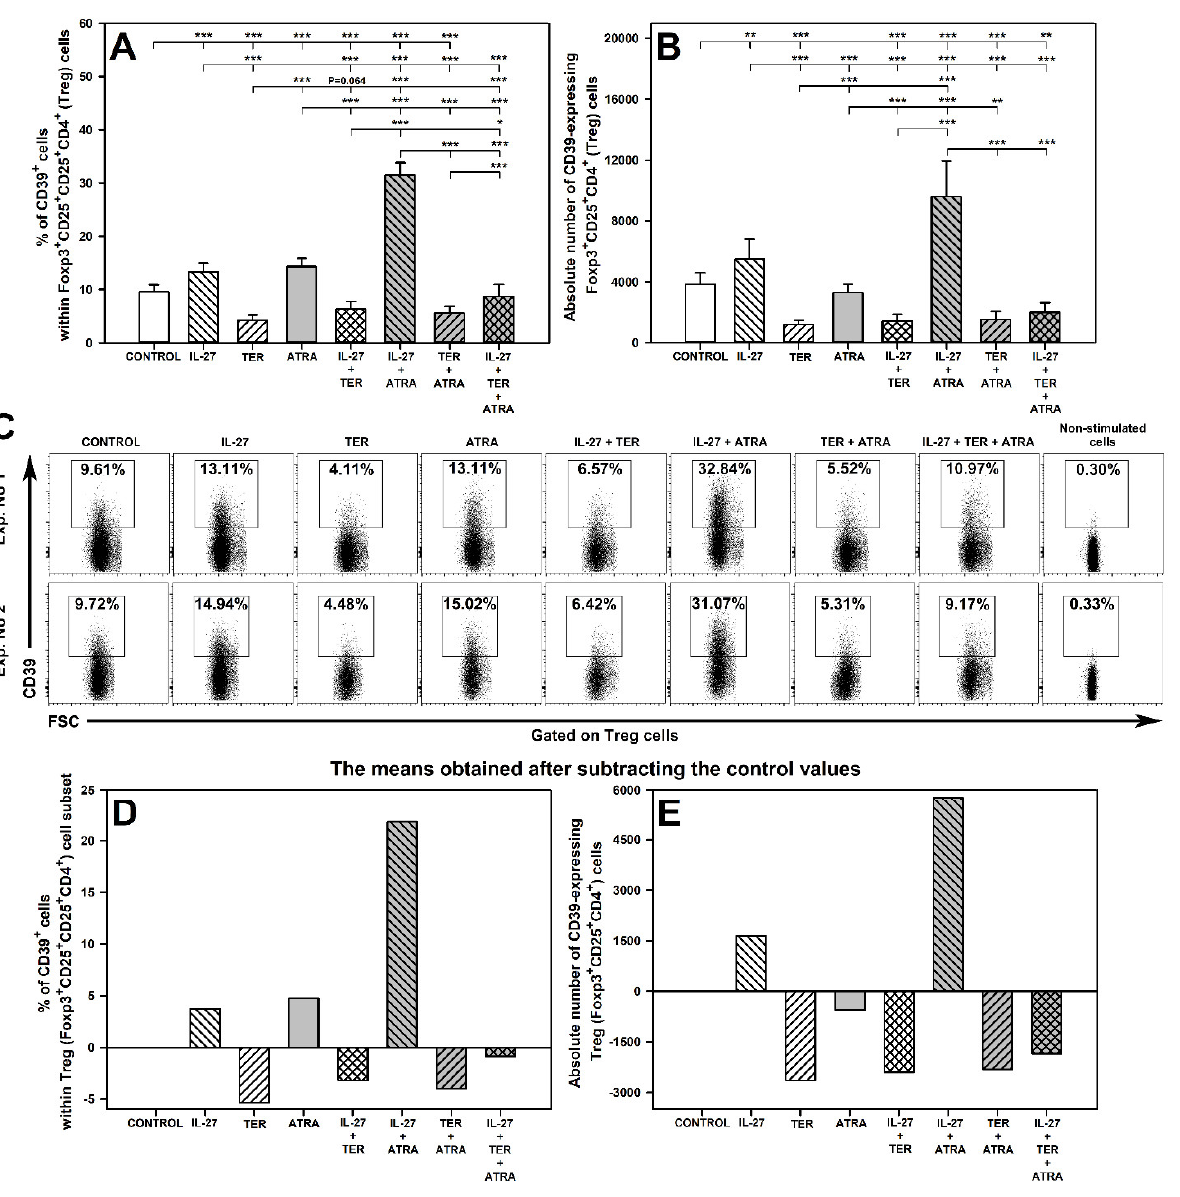
Figure 4. Effect of IL-27, teriflunomide (TER), all-trans-retinoic acid (ATRA), and their combinations on the number of CD39-expressing Foxp3 + CD25 + CD4 + regulatory T (Treg) cells under activation conditions. The relative ( A ) and absolute count ( B ) of these cells were determined in cell cultures incubated in the absence (CONTROL) and presence of IL-27 (100 ng/mL), TER (10 − 4 M), and ATRA (10 − 6 M) for 72 h including concomitant stimulation with IL-2, anti-CD3, and anti-CD28 and re-stimulation with PMA and ionomycin for the last 5 h before harvest. Unstimulated cells served as a negative control for the cell activation. The relative count is expressed as a percentage of CD39-expressing cells within Foxp3 + CD25 + CD4 + T cell subset ( A ). The absolute count represents the number of CD39 + Foxp3 + CD25 + CD4 + T cells per sample well ( B ). Results are expressed as the mean ( ± S.D.) of three independent experiments with 4 mice per experiment (overall n = 12, * p < 0.05, ** p < 0.01, *** p < 0.001). Examples of dot plot cytograms for all treatments show the distribution of CD39-expressing cells within Foxp3 + CD25 + CD4 + T cell subset ( C ). Additionally, in order to better visualize the superadditive synergism between IL-27 and ATRA in the induction of CD39 expression on Treg cells, the mean of the relative ( D ) and absolute count ( E ) of studied cells was showed after subtracting the control